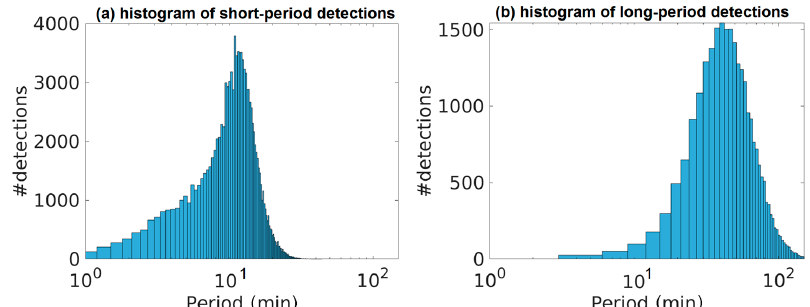
Figure 4. The histograms refer to the period at the maximum amplitude within each detection family, recorded at IS33. The short-period distribution ( a ) is centered at a period of 13 min; whereas the long-period distribution ( b ) peaks at around 60 min. Please note the different scaling in the number of detections and the bandwidths.